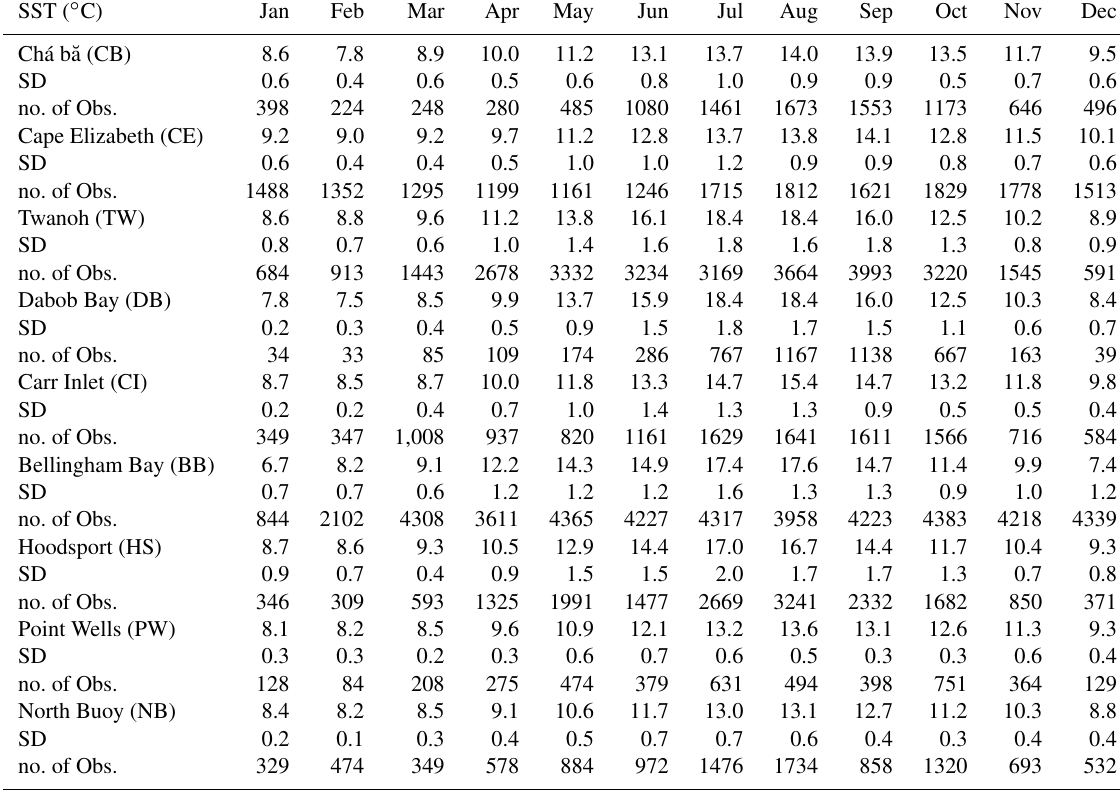
Table C2. Average monthly SST seasonal cycles for the nine Washington State moorings. The average monthly standard deviation (SD) and total number of observations (no. of Obs.) contributing to the monthly average estimate are included. SST ( ◦ C)